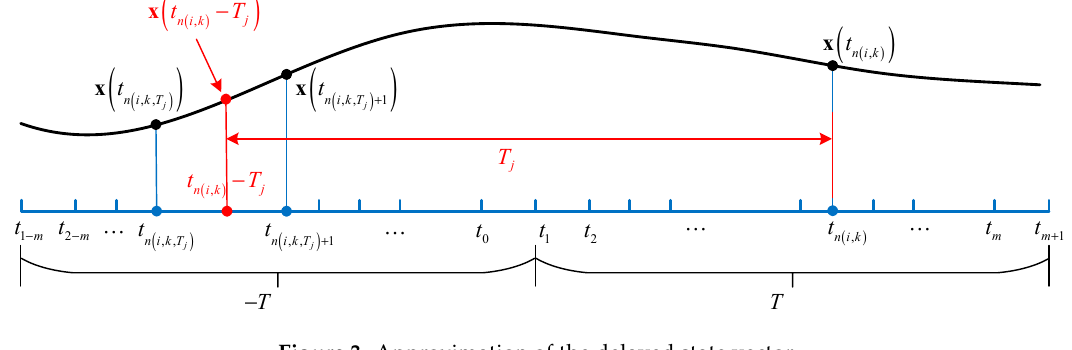
Figure 3. Approximation of the delayed state vector.